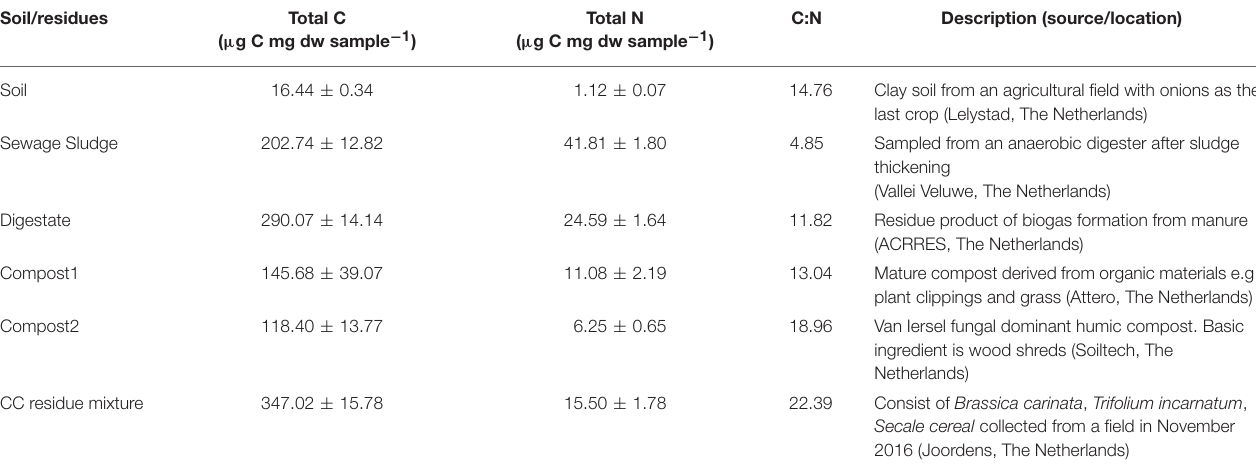
TABLE 1 | Amendment description, total C and N contents of amendment and soil.